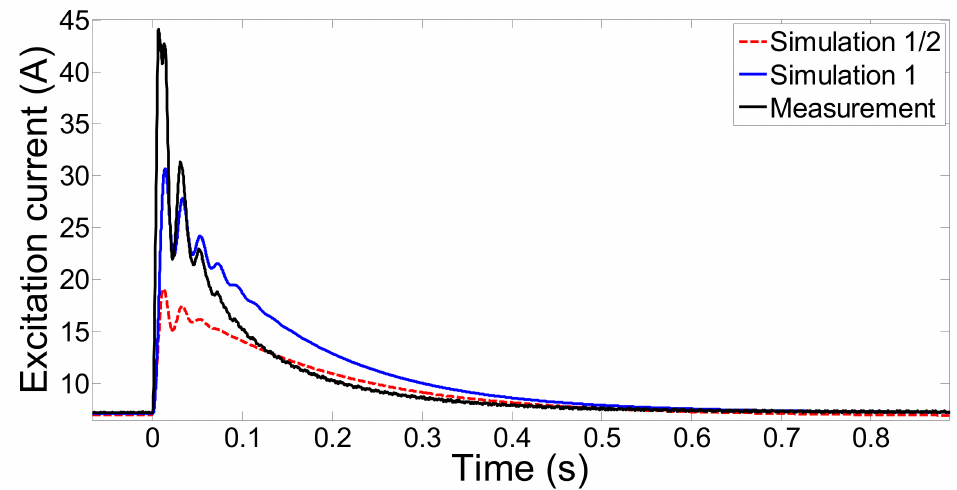
Figure 7. Comparison of simulation and measurement for the short-circuit excitation current.